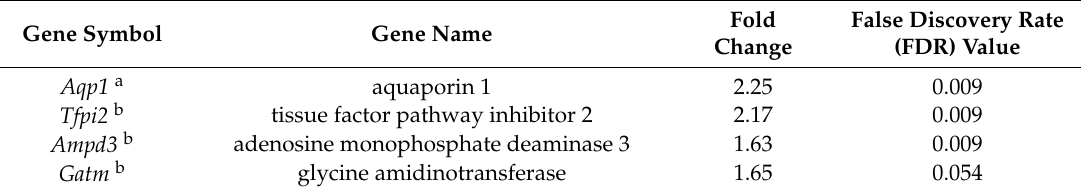
Table 1. Differentially-expressed imprinted genes in the female placentas in response to 4X versus 1X maternal choline supplementation 1